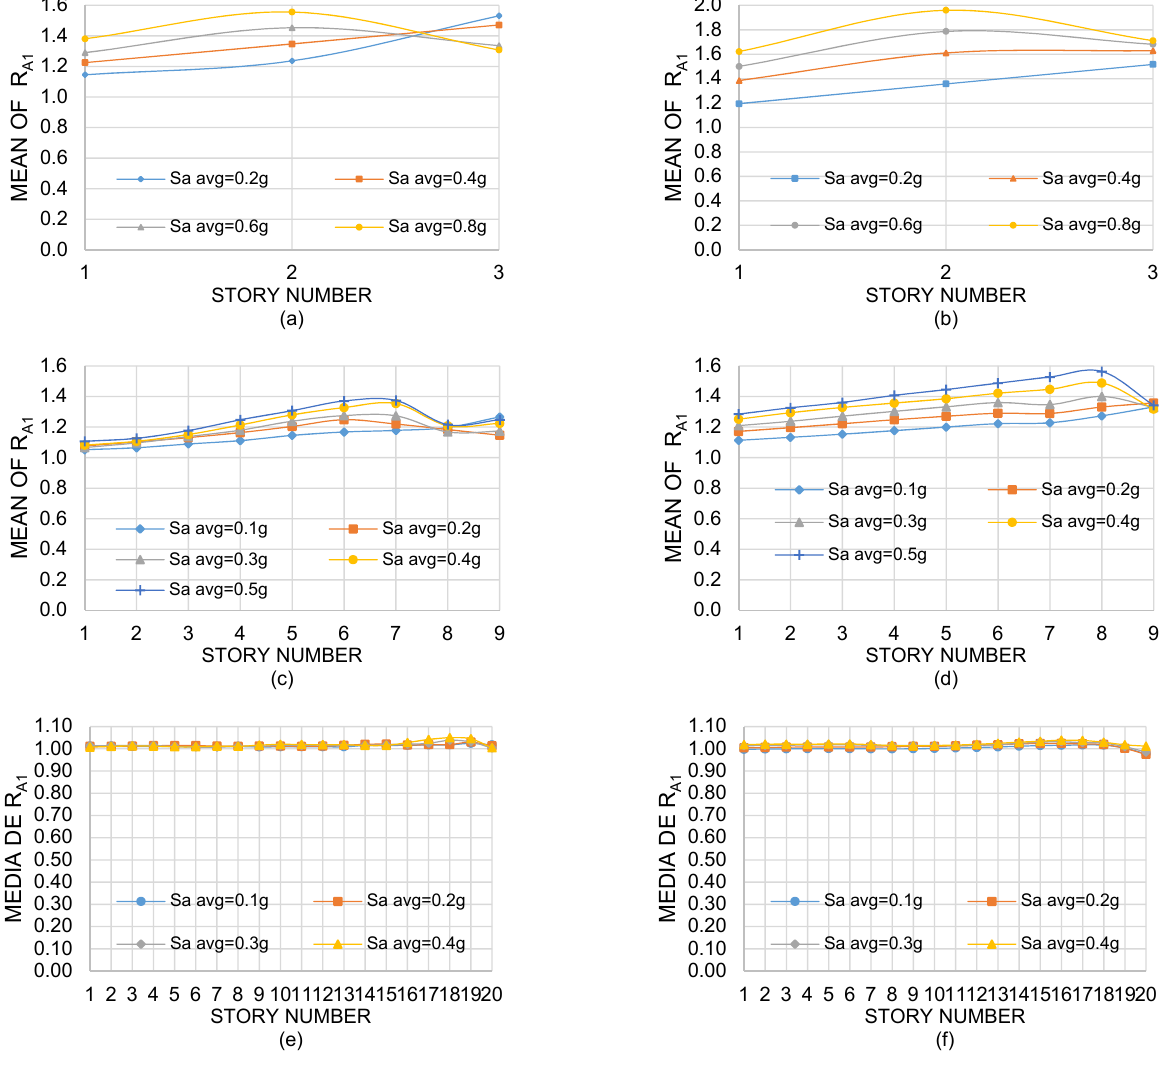
Figure 11. Mean values of R A 1 , NS direction: ( a , c , e ), exterior columns of Models 1-2-3, respectively; ( b , d , f ), interior columns of Models 1-2-3, respectively.